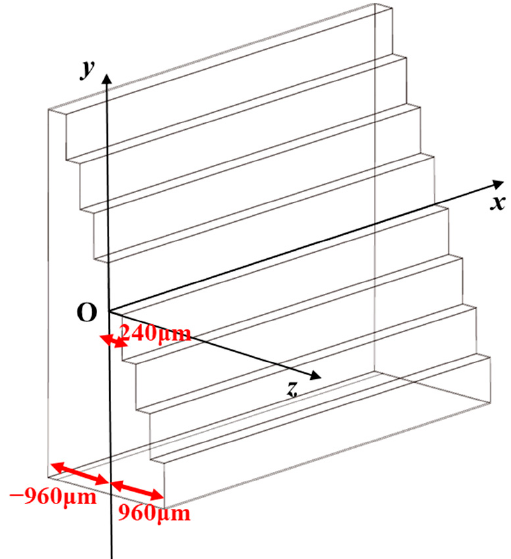
Figure 5. The schematic diagram of the higher stepped micromirror clearly expresses the maximum height difference caused by the stepped structure. height difference caused by the stepped